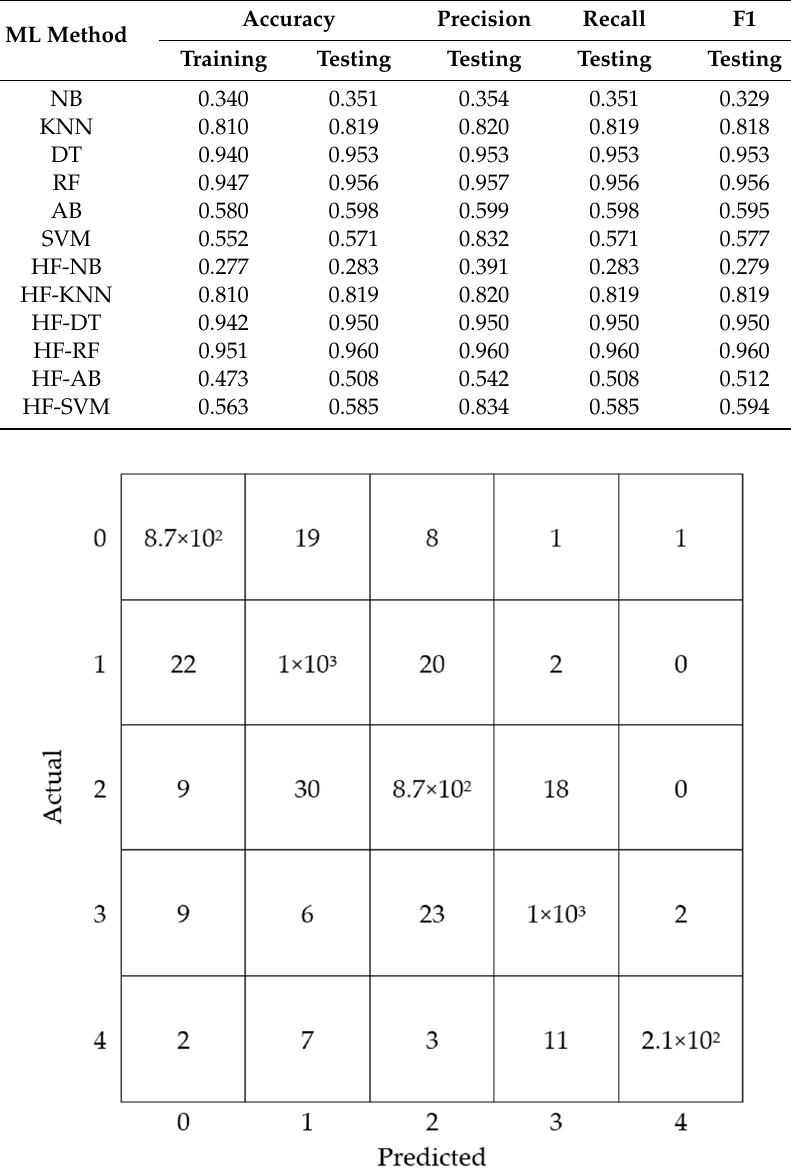
Table 7. Floor classification results.